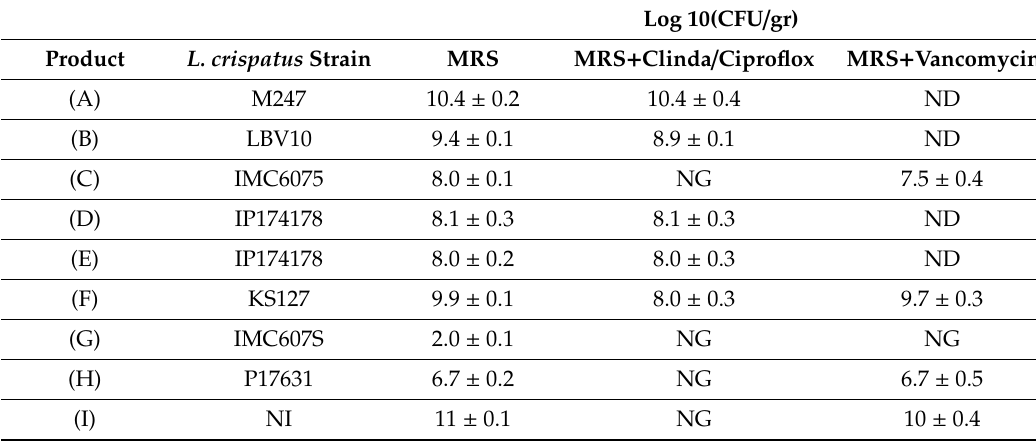
Table 2. Logarithmic transformed mean values (CFU / g) of viable counts for three independent replicates and SD obtained for products on di ff erent